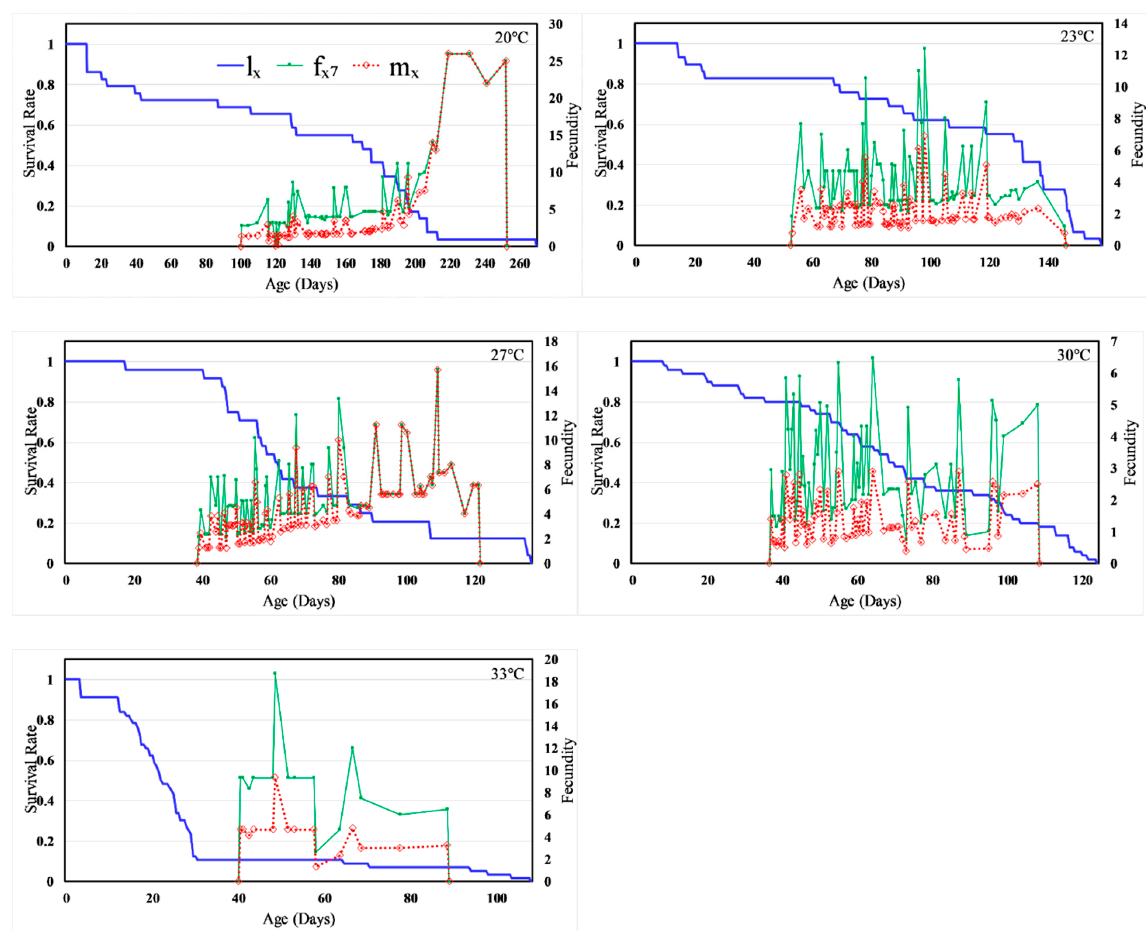
Figure 2. Temperature dependent age-specific survival rate (lx), female age-stage-specific fecundity ( f x 7 ), and age-specific fecundity (mx) of H. halys